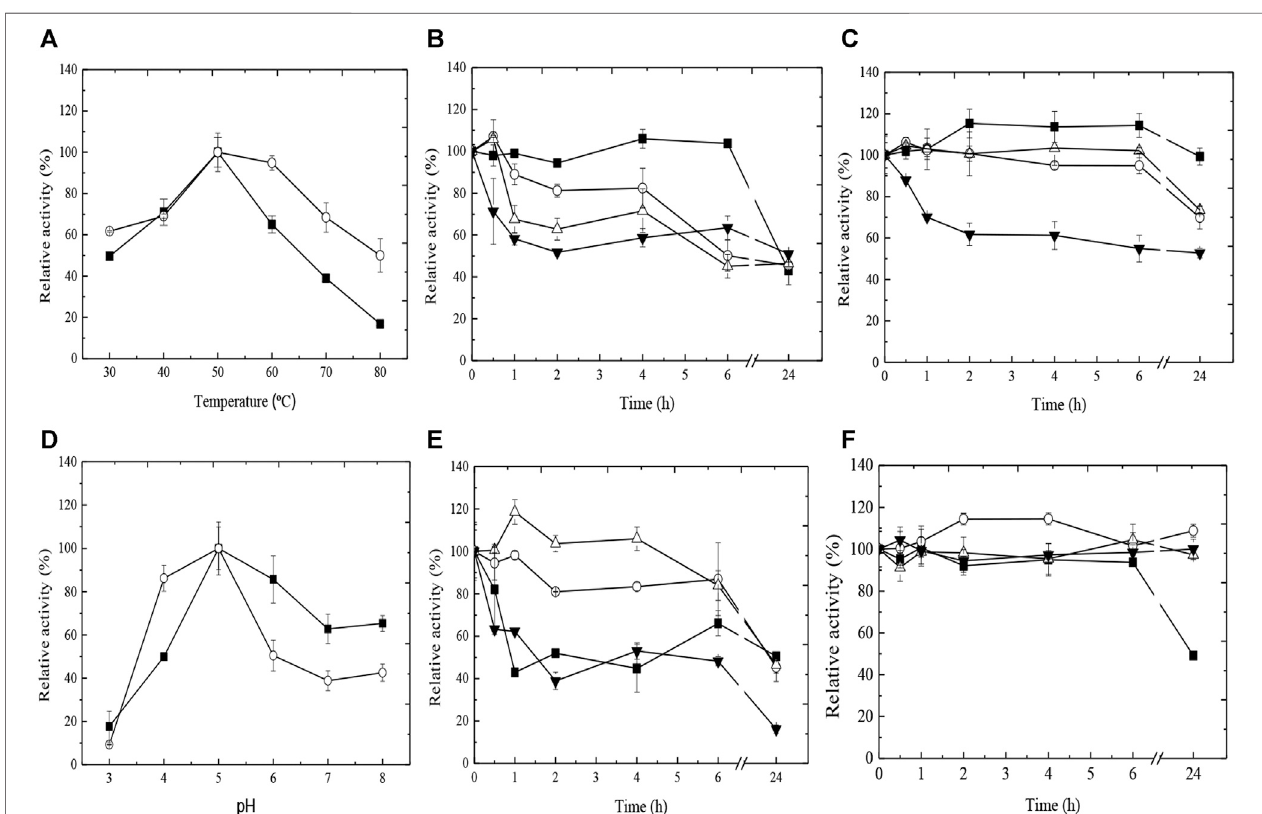
FIGURE2| Effectoftemperature (A) andpH (D) ontheenzymaticactivityoffree( ■ )andimmobilized( ○ )tannasesfrom A.fumigatus CAS21.Thermal (B,C) andpH (E,F) stabilitiesoffree (B – E) andimmobilized (C – F) tannasesfrom A.fumigatus CAS21.Symbols:for (B,C) ,30 ° C( ■ ),40 ° C( ○ ),50 ° C( Δ ),and60 ° C( ▼ )for24 h;for (E,F) , pH 4.0 ( ■ ), 5.0 ( ○ ), 6.0 ( Δ ), and 7.0 ( ▼ ) for 24